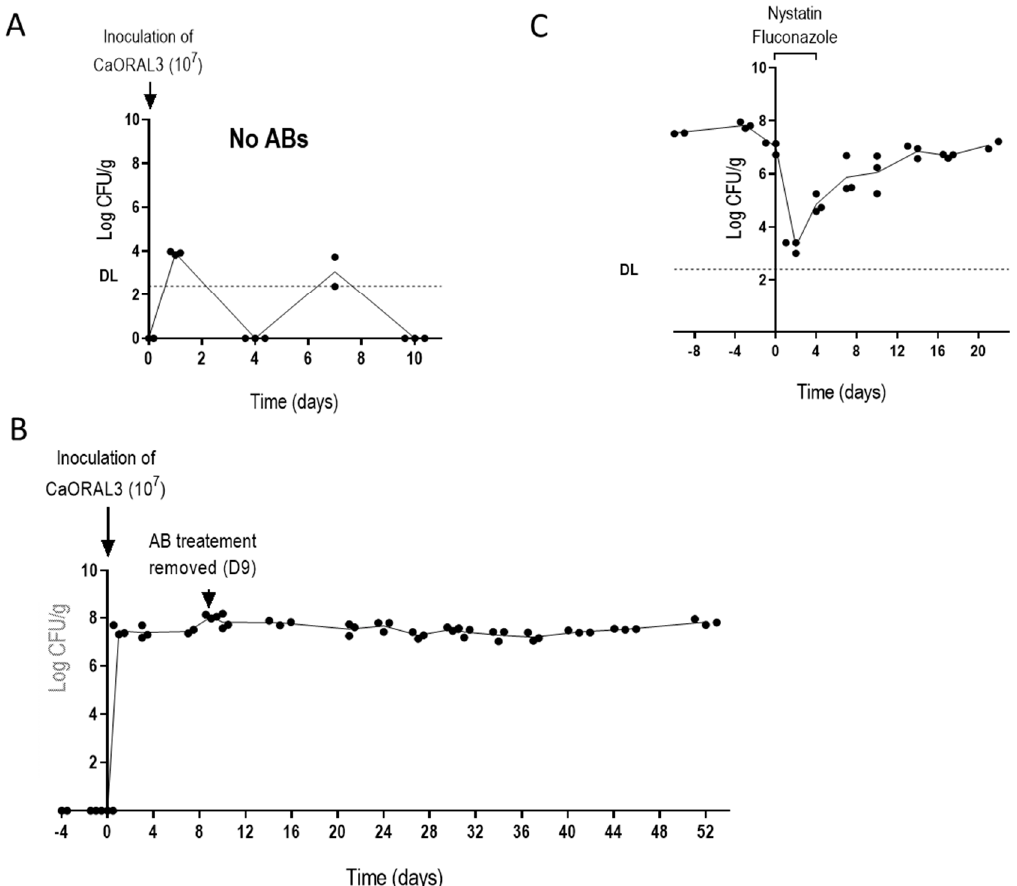
Figure 4. Effect of the antibiotic treatment on CaORAL3 colonization. ( A ) A suspension of CaORAL3 cells was inoculated in non-antibiotic treated mice. ( B ) CaORAL3 cells were inoculated in Ab-treated mice 4 days prior plus 9 days after C. albicans inoculation. Colonization rate was followed in time and expressed as Log CFUs per g of stools. ( C ) Effect of nystatin and fluconazole administration over CaORAL3 colonization rate.